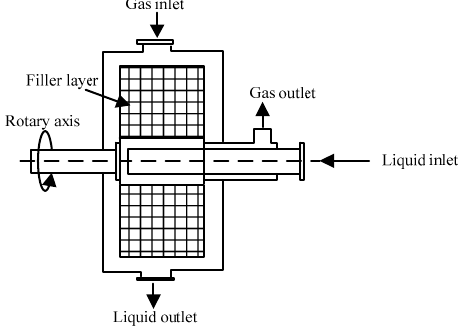
Figure 3. Structural sketch of the Higee.